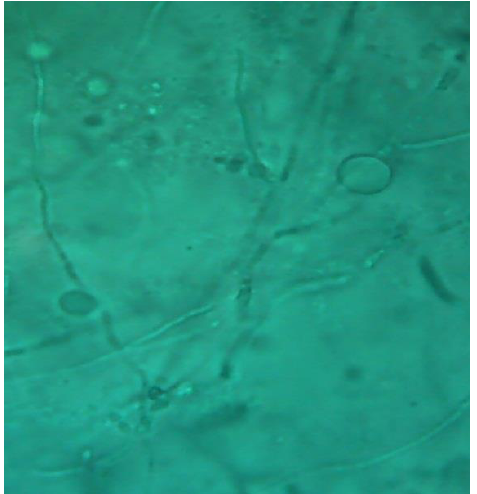
Figure 1. Chlamydospore of C. albicans by lactophenol mount.